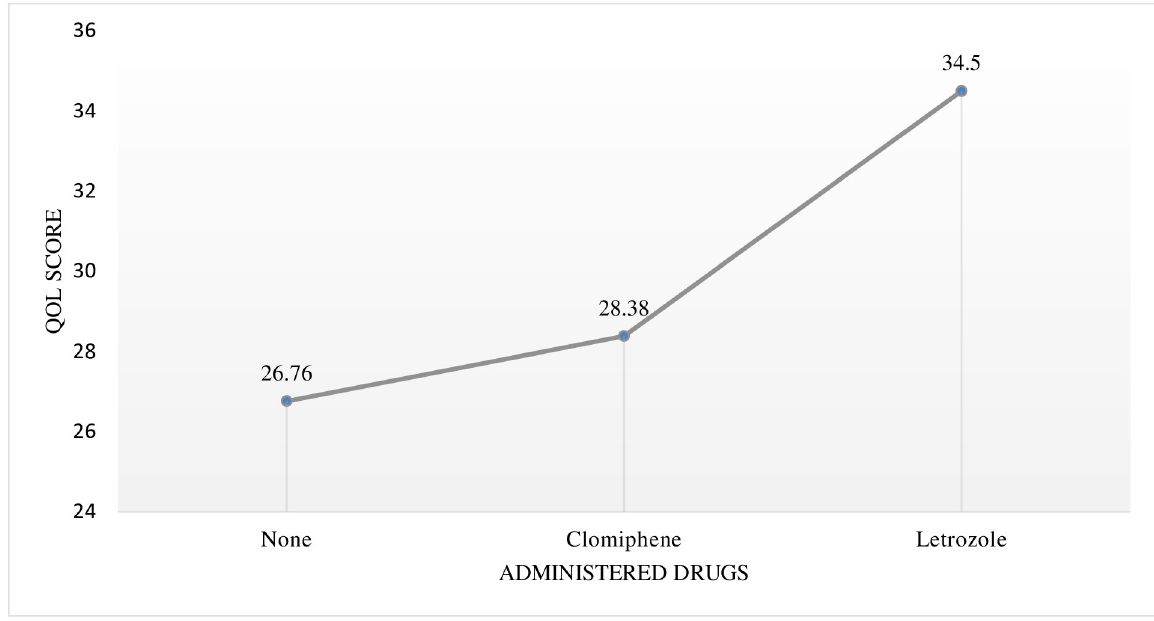
Fig 3. Line graph showing the comparison of the mean quality of life (QOL) scores among patients receiving infertility drugs.